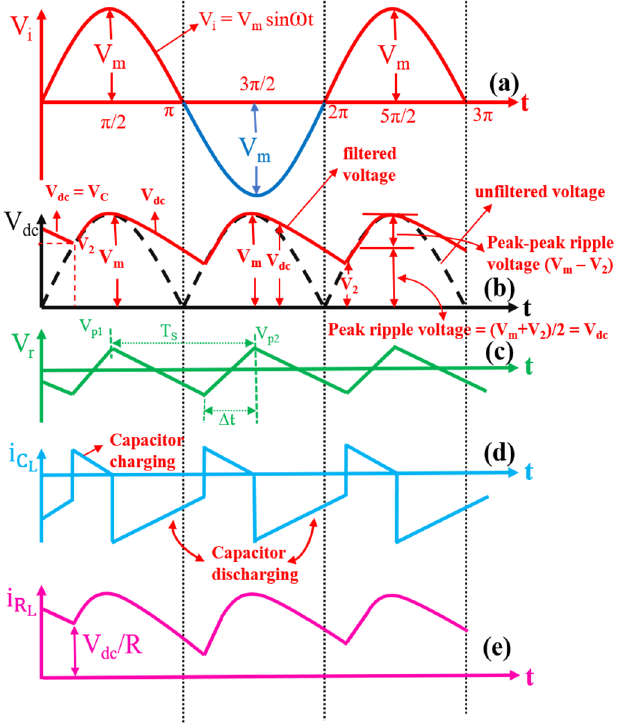
Figure 4. Various output waveforms of an FBR circuit (neglected C P ): ( a ) PD voltage, V i , ( b ) Rectified voltage, V dc , ( c ) Ripple voltage, V r , ( d ) Current through load capacitor, i CL and, ( e ) Current through resistor, i RL .